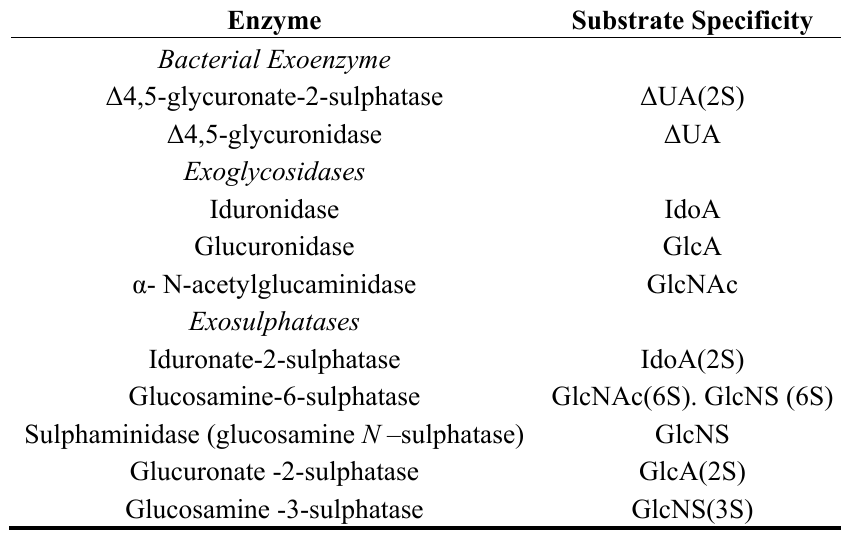
Table 1. Exoglycosidases and exosulphatases for HS structural analysis. Sulphatases remove sulphate groups from the non-reducing end (NRE) and glycosidases cleave the whole non-sulphated monosaccharides. Information as taken from